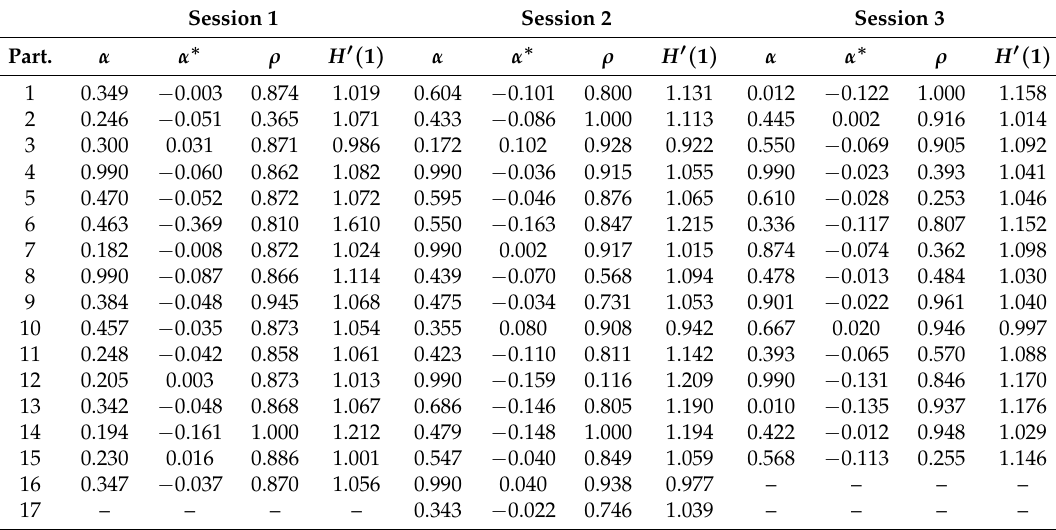
Table 13. Fitted parameters for exponential smoothing with non-monotonic H model ( ESHE ) for the three sessions. Session 1 Session 2 Session 3